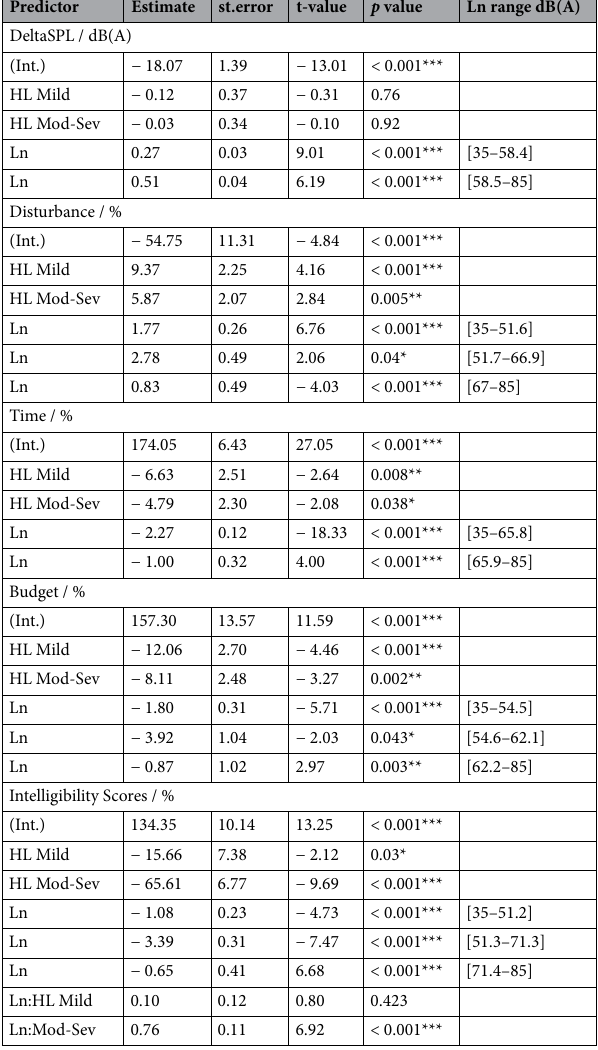
Table 1. Piecewise Linear model output for four models with response variables DeltaSPL, Disturbance, Time and Budget as a function of Ln and Hearing Loss (with reference level equal to Normal Hearing).